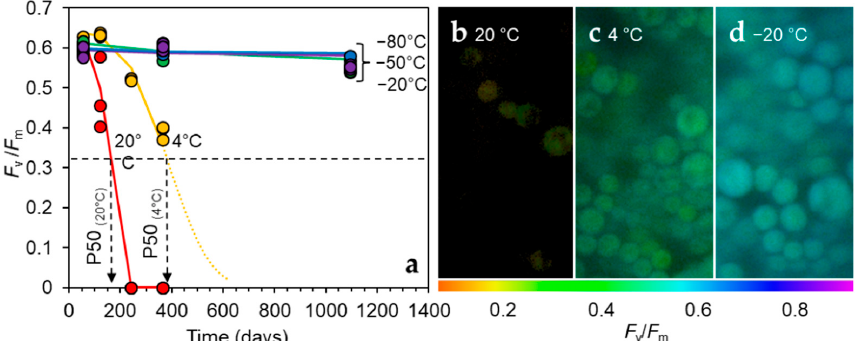
Figure 2. Effect of temperature on longevity of cells equilibrated to 50% RH before storage in aluminum foil wraps. ( a ) Chlorophyll fluorescence-derived F v / F m values after 48 h of rehydration, used as a cell viability indicator. F v / F m values from ( a ), but as images of individual cells using a false-color scale (below) after 1 year in storage at ( b ) 20 °C, ( c ) 4 °C, and ( d ) − 20 °C. Table 1. Effect of storage conditions on H. lacustris cell longevity